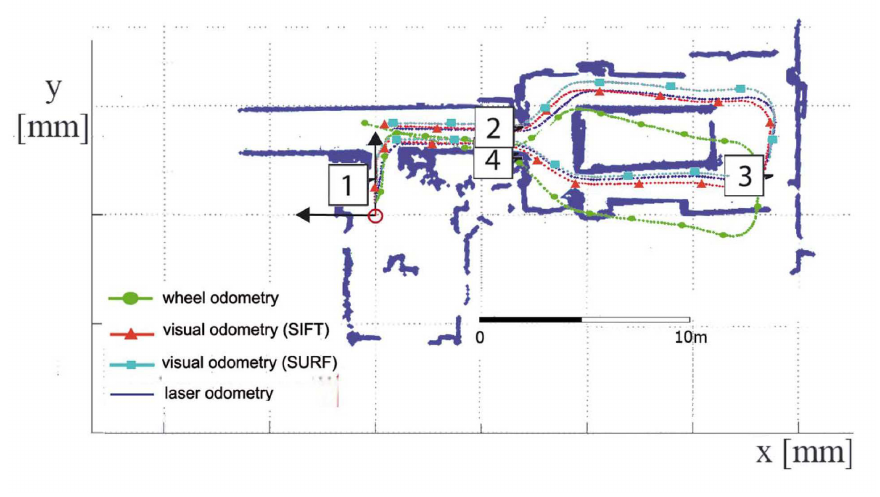
Figure 13. Trajectories estimated by visual (Harris, SIFT and SURF) and wheel odometry (black, red, cyan and green lines, respectively) for the second reported test. Blue line defines the trajectory estimated by the laser scan matching. Blue dots represent the map obtained using the scan data acquired by the laser range finder. Robot poses at the captured times marked over Figure 12.